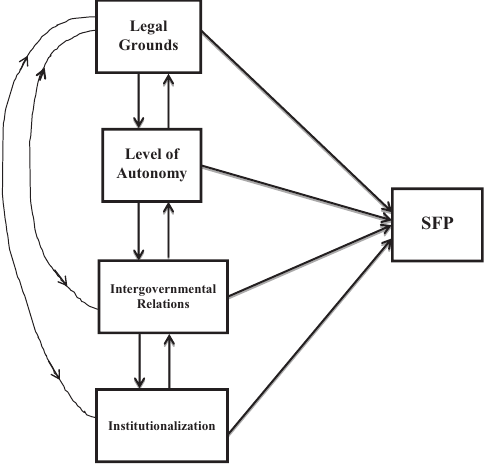
Figure 1. Domestic structure and